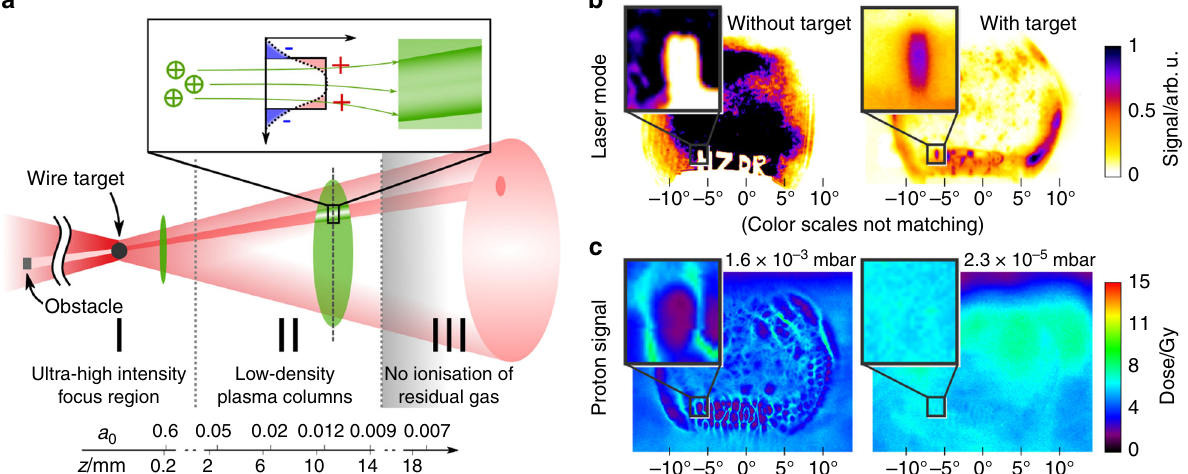
Fig. 2 Imprint scheme and experimental imprinting results. a Schematic depiction of the imprint scenario, visualizing the transmitted laser path (red cone) and the accelerated proton bunch (green) along the propagation axis z . Between target and proton beam diagnostic, three main regions are identi fi ed and related to the transmitted laser intensity expressed via a 0 . Spatial fi ltering in the laser focus results in the emphasis of high spatial laser frequencies, for example those related to obstacles inserted in the beam before focusing. In areas of suf fi cient transmitted laser intensity, residual gas molecules are ionized locally and low-density plasma columns extending along z are formed until the laser intensity has dropped below the ionization threshold. In the quasi- neutral region II, transverse quasi-static electric fi elds between the plasma electrons and the remaining fi xed ions are visualized via radiography with the accelerated protons as intrinsic probe. b Transmitted laser intensity mode without (left) and with (right) a 10 μ m diameter tungsten wire positioned in the laser focus. The color scale for each picture was adjusted to ensure visibility of important features. c Proton beam pro fi le (4.7 MeV layer displayed) at two different residual gas pressures in the experimental chamber. In the left image, structures corresponding to the obstacles inserted in the laser beam can be observed, as well as features originating from fl uctuations intrinsic to the laser beam pro fi le. By decreasing the pressure the imprint effect can be switched off almost completely (right image). The change in overall dose between both cases is within the range of shot-to-shot variations of the proton acceleration transmitted laser pulse propagates through region II, which can inherent to diffraction of the laser at sharp edges of inserted reach up to >10 mm, depending on the given experimental obstacles in Fig. 1. Note that the ionization rate of residual gas parameters, these ionized areas extend to low-density plasma molecules by hot electrons escaping the target is only in the order columns containing free electrons behind the laser pulse. The of one event ms − 1 cm − 3 and can therefore be omitted 43 . As the